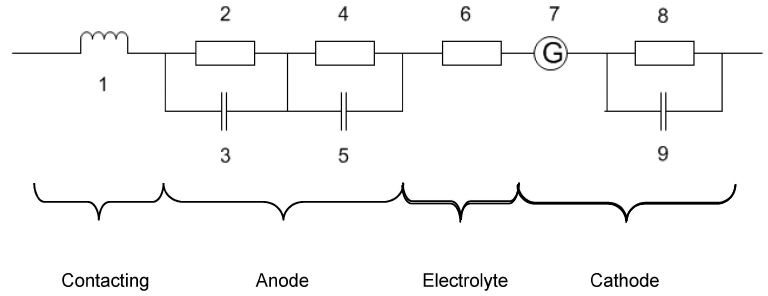
Figure 11. Equivalent circuit for calculation of MEA impedance.